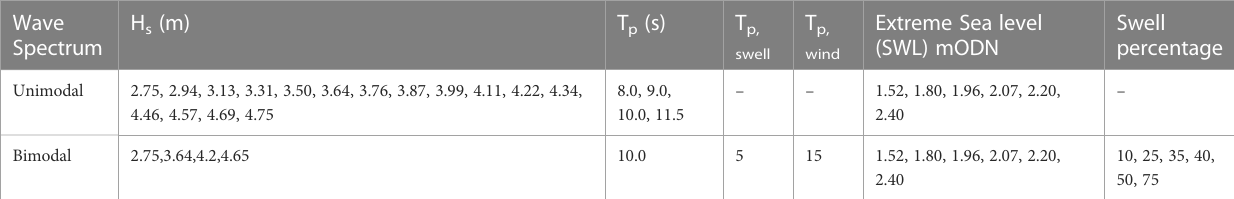
TABLE 3 Entire set of conditions used to develop synthetic